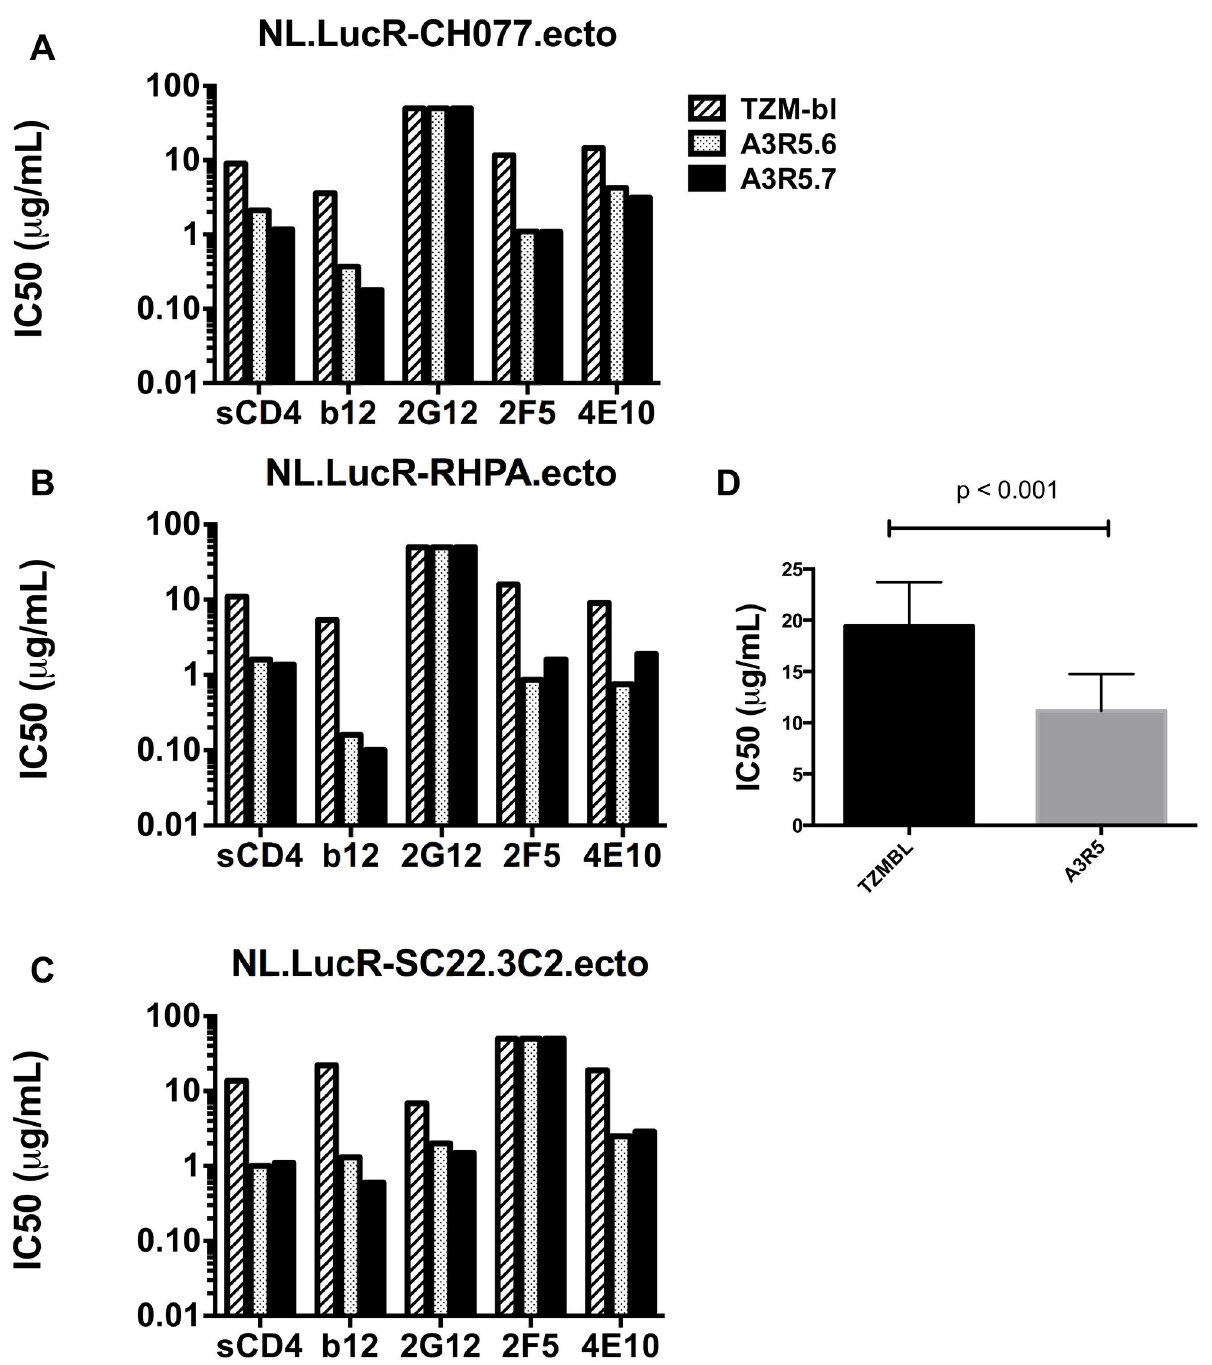
Figure 3. Subtype B neutralization in A3R5 cells and TZM-bl. A - C . Neutralization sensitivity of three tier 2 subtype B IMC.LucR transmitted/founder viruses to sCD4 and a panel of four mAbs in two A3R5 cell lines and TZM-bl . With the exception where no inhibition was noted for any cell line, the A3R5 cell lines showed greater neutralization for all inhibitors tested compared to TZM-bl. D . Grouped inhibitor comparison between cell lines . When grouped by cell line using the non-parametric Mann-Whitney test, there was a significant difference between the A3R5 cell lines and TZM-bl (Mann-Whitney test; p<0.001). IC50 titers are the concentration of inhibitor at which the Renilla luciferase signal (RLUs) was reduced by 50% compared to the virus control (no inhibitor). Inhibitor concentrations ranged from 0.78 μg/mL to 25 μg/mL. All assays were performed in the presence of DEAE-Dextran. doi: 10.1371/journal.pone.0077756.g003 PLOS ONE |